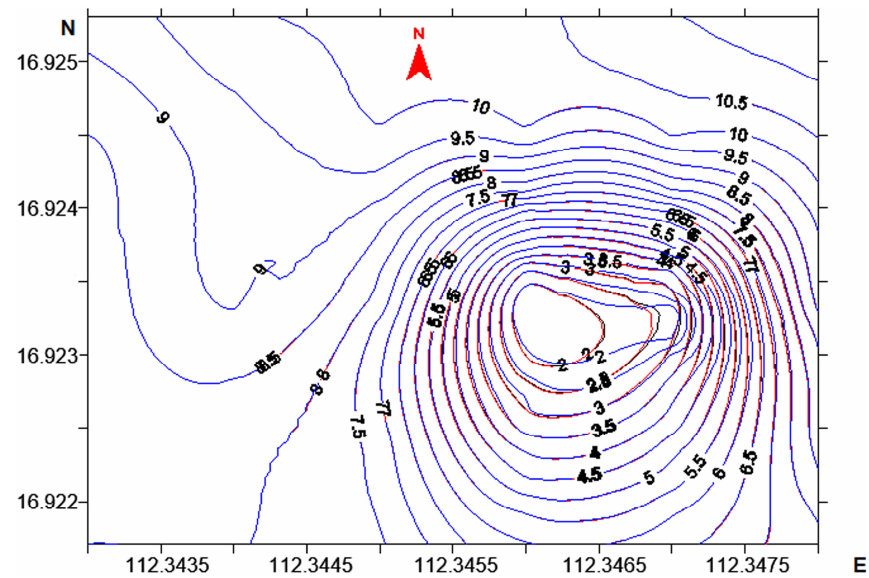
Figure 11. Underwater topography changes in the newborn sandbank under 1 month of wave action with the maximum wave height in the dominated wave direction. (The red lines are the initial underwater topography, and the blue lines are the new underwater topography after 1 month of wave action).